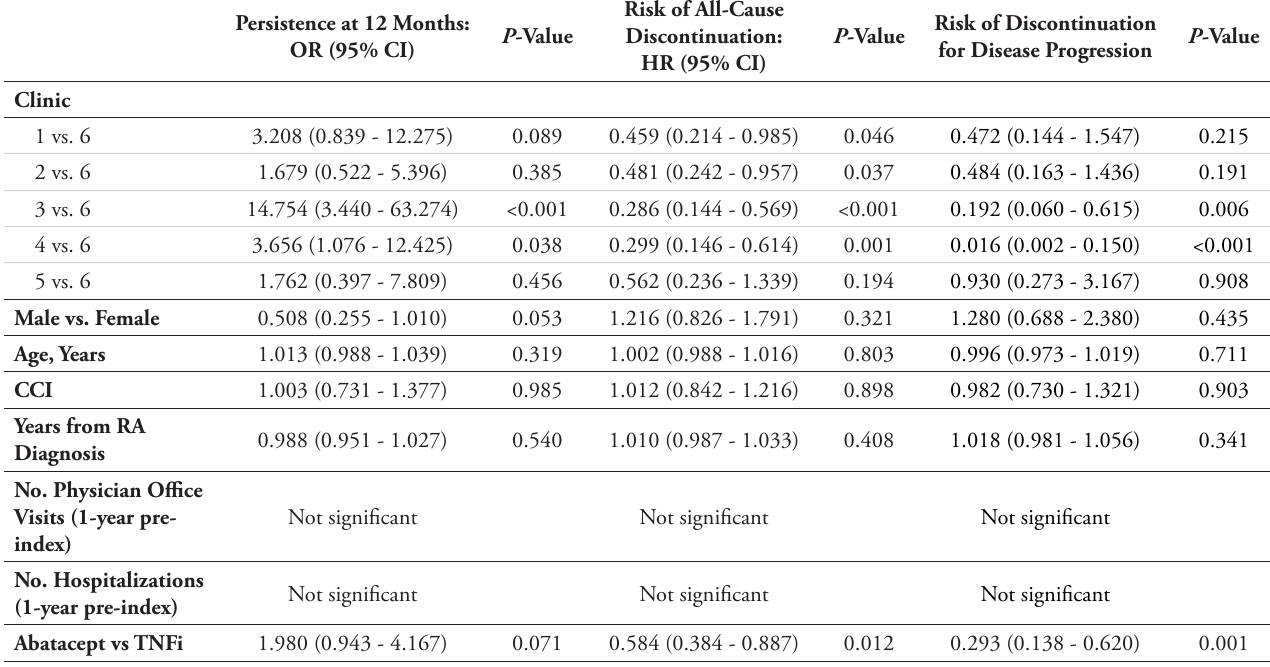
Table 3. Adjusted Treatment Persistence and Risk of Discontinuation Among All Patients (N=265) a